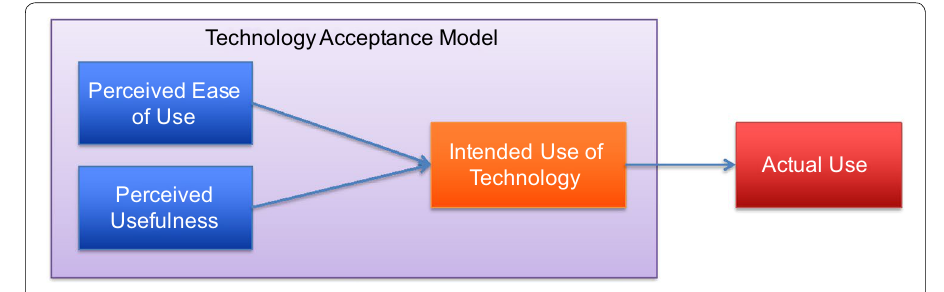
Fig. 4 Original technology acceptance model (Source: [9,